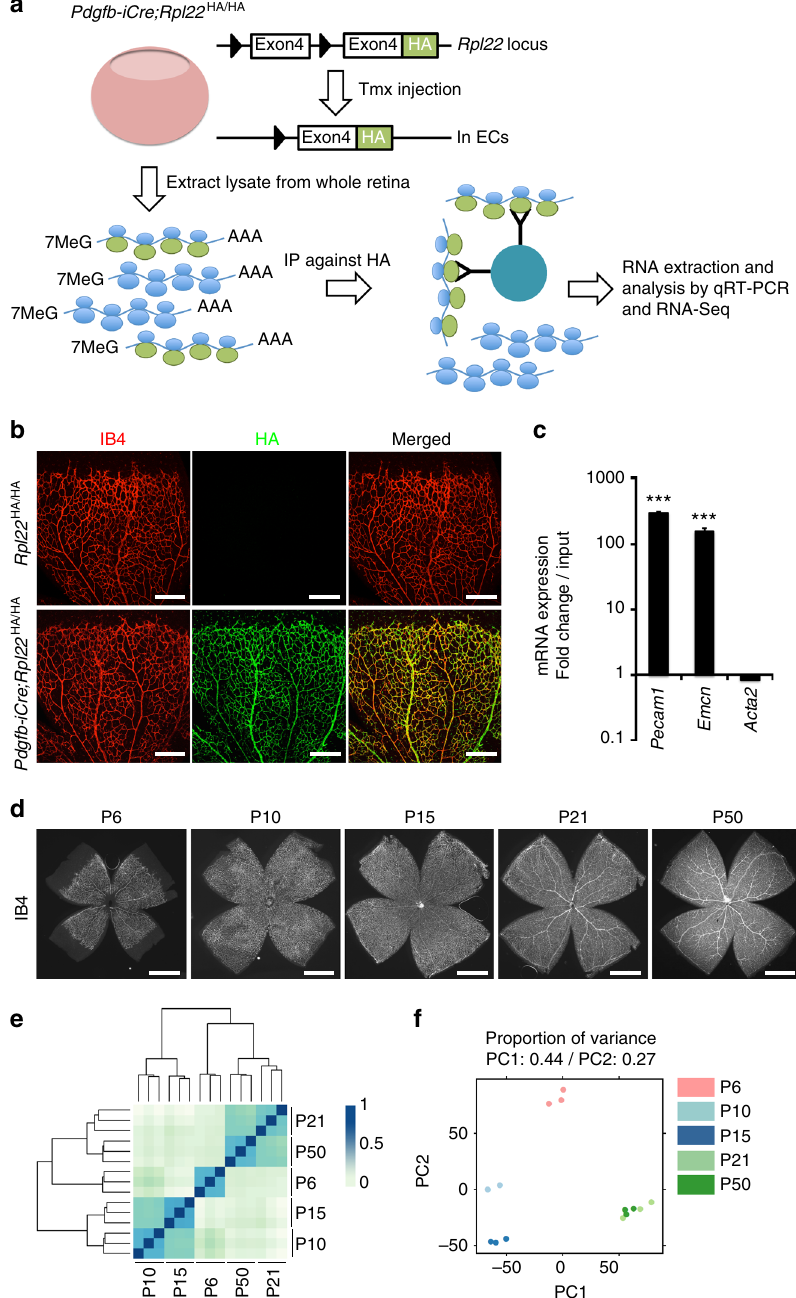
Fig. 1 RiboTag analysis of retinal ECs during postnatal development. a Diagram depicting retinal EC-speci fi c RiboTag transcriptome analysis. Inducible (Tmx controlled) recombination of the RiboTag allele ( Rpl22 HA/HA ) led to expression of HA-tagged L22 ribosomal protein speci fi cally in ECs. Ribosome-bound transcripts were immunoprecipitated (IP) from homogenized whole retinas with anti-HA antibody-coupled magnetic beads. Extracted mRNAs were analyzed by RT-qPCR or RNA-Seq analysis. b P6 Rpl22 HA/HA (control) and Pdgfb-iCre Rpl22 HA/HA retinas stained with Isolectin B4 (IB4, red ) and anti-HA antibody ( green ). Scale bars represent 300 μ m. c RT-qPCR analysis of transcripts expressed in retinal ECs. EC-speci fi c markers, Pecam1 and Emcn , and Acta2 negative control were normalized to Actb levels using ΔΔ CT method. Anti-HA immunoprecipitated RNAs were compared to whole retinal lysate input. Error bars represent mean ± s.e.m., n = 6, *** P < 0.0001; unpaired Student ’ s t -test. d IB4 staining of whole retinas at P6, P10, P15, P21, and P50 showing vascularization during postnatal development. Scale bars represent 0.5 mm. e Unsupervised hierarchical clustering of 15 retinal EC RNA-Seq data sets with three replicates per stage. f Two-dimensional principal component analysis (PCA) plot showing the discrimination of gene expression pro fi les between retinal ECs from different